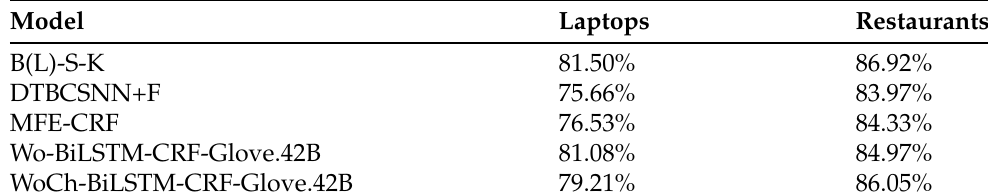
Table 3. Comparison of F-score results of baseline methods for SemEval-14.